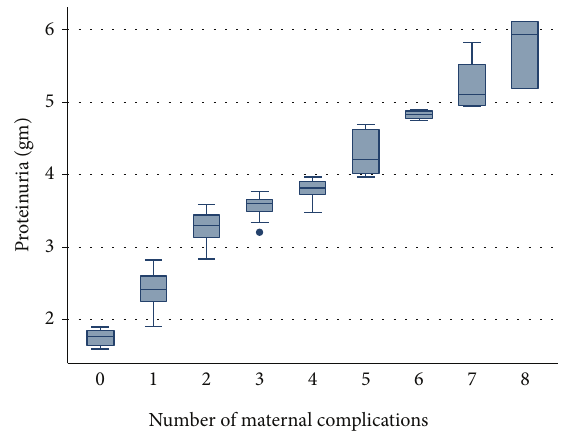
Figure 1: The relationship between the numbers of maternal complications and amount of proteinuria (measured as spot UPCR as gm/gm) in the patients of preeclampsia.